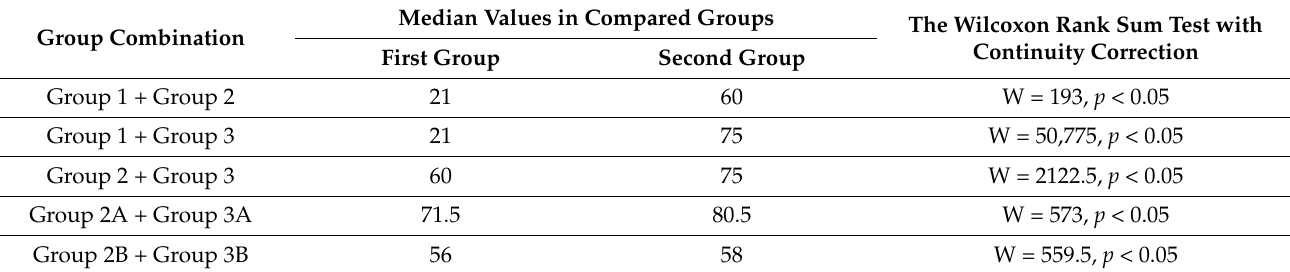
Table 3. Difference in age distribution in the studied samples.